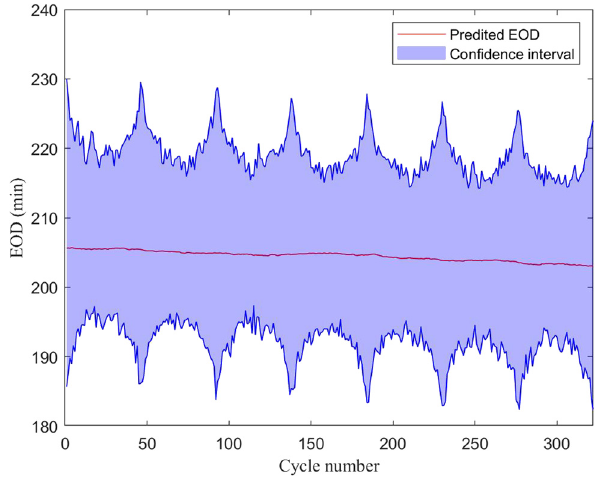
Figure 7: Predicted EOD of each cycle.